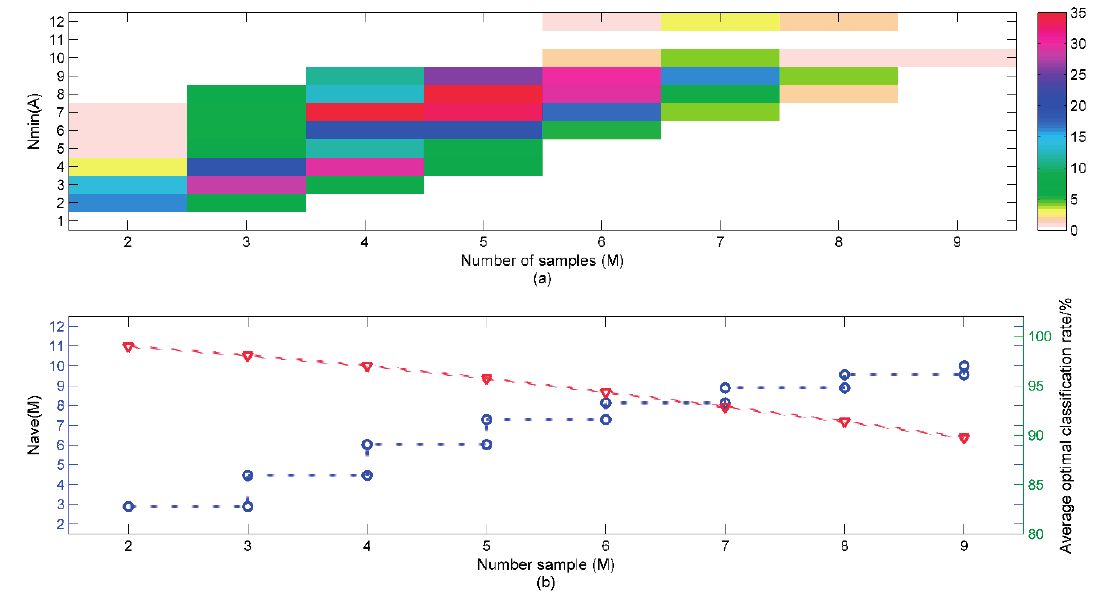
Figure 6. ( a ) Distribution of the sample sets with M samples, color bar indicates the number of the sample; ( b ) The average N ave ( A ) (circle) of sample sets with M samples and corresponding optimal classification performances (triangle).